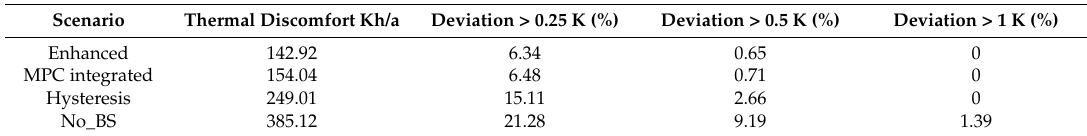
Table 7. Accumulated thermal discomfort in the south oriented office zone for the whole year and fraction of office time out of the comfort band for different temperature